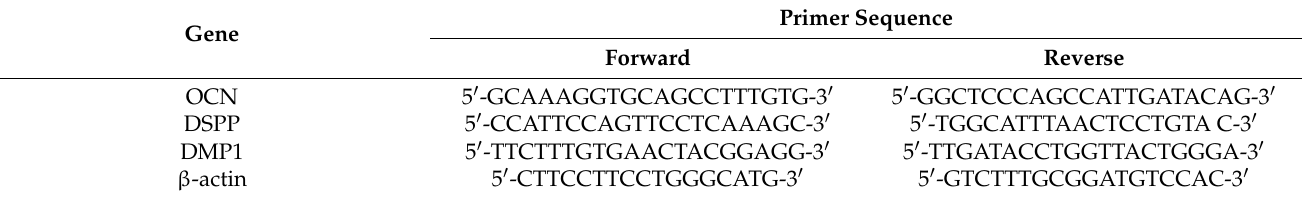
Table 1. Real-time PCR primer sequences of the genes coding osteocalcin (OCN), dentin sialophosphoprotein (DSPP), and dentin matrix protein 1 (DMP1) and β